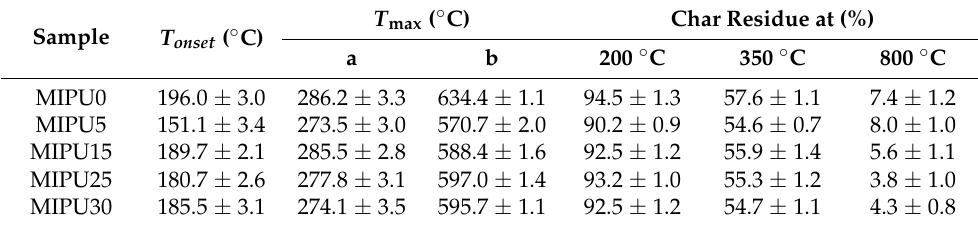
Figure 5. ( a ) TG and ( b ) DTG curves of the coatings. Table 1. Extracted TG and DTG data.